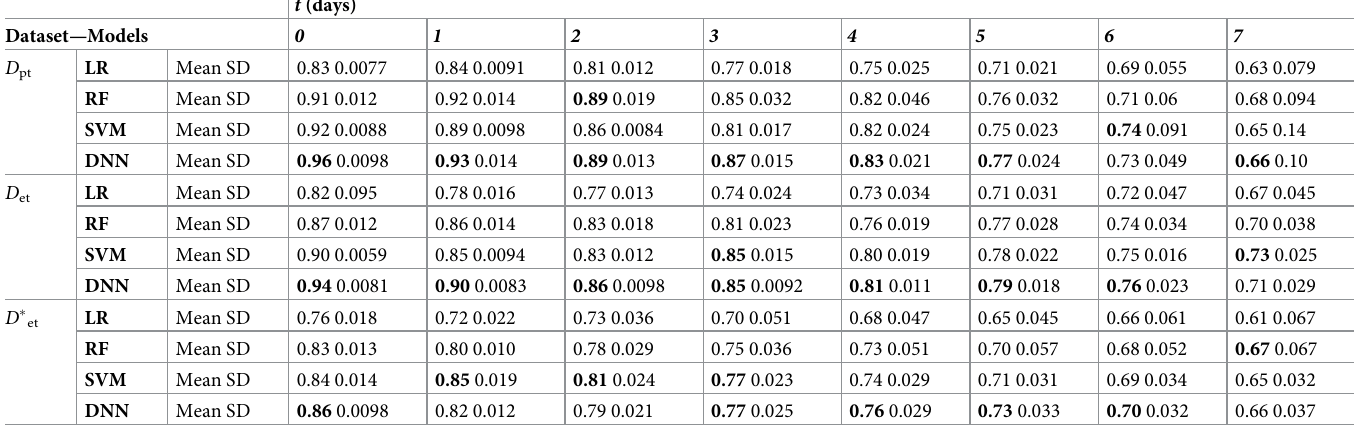
Table detailing the mean PPV and 1-standard deviation for the LR, RF, SVM and DNN models trained and tested on the different sub-datasets containing planned admissions, D , emergency admissions, D and emergency admissions with an infection, D � pt et